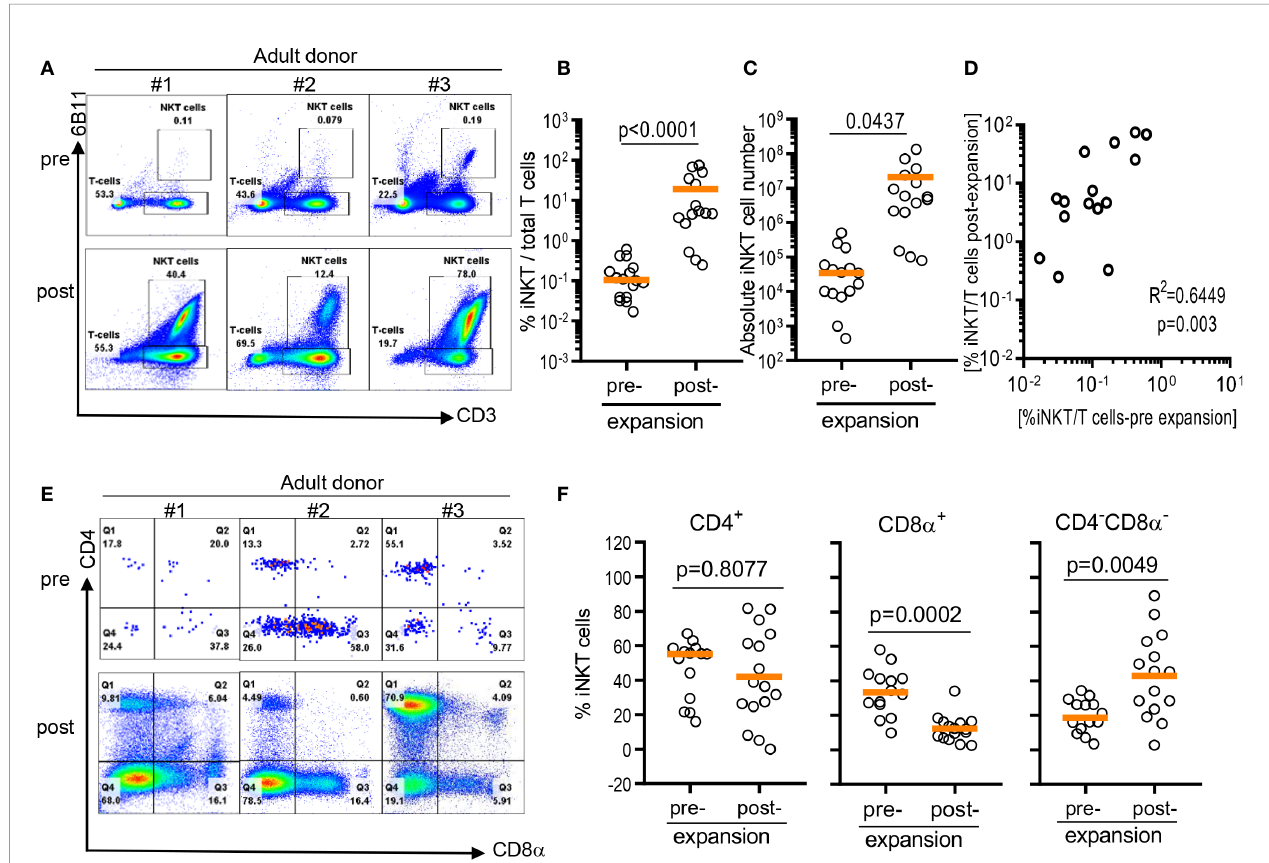
FIGURE 1 | Direct antigenic stimulation of iNKT cells from peripheral blood mononuclear cells (PBMCs). (A) We performed fl ow cytometry analysis pre (day 0) and post (day 10) that iNKT cells gated on 6B11 and CD3. Fresh isolated iNKT cells from 3 healthy donors were stimulated with a GalCer pulsed PBMCs by use of 200 nM/ml a GalCer in the presence of 200 U/ml IL-2 for 10 days. (B) iNKT cells from 15 healthy donors were stimulated with a GalCer pulsed PBMCs by use of 200 nM/ ml a GalCer in the presence of 200 U/ml IL-2 for 10 days. The percentage indicates the 6B11 + and CD3 + iNKT cells. (C) Absolute numbers in pre- and post- expansion from direct antigenic stimulation of iNKT cells from PBMCs. (D) Linear regression showing the correlation between the percentage of pre and post of iNKT cells in healthy donor samples. (E, F) Analysis of the phenotype of CD4 + , CD8 a + , and CD4 - CD8 - iNKT cells at day 10. A paired t test was used to compare the differences between selected